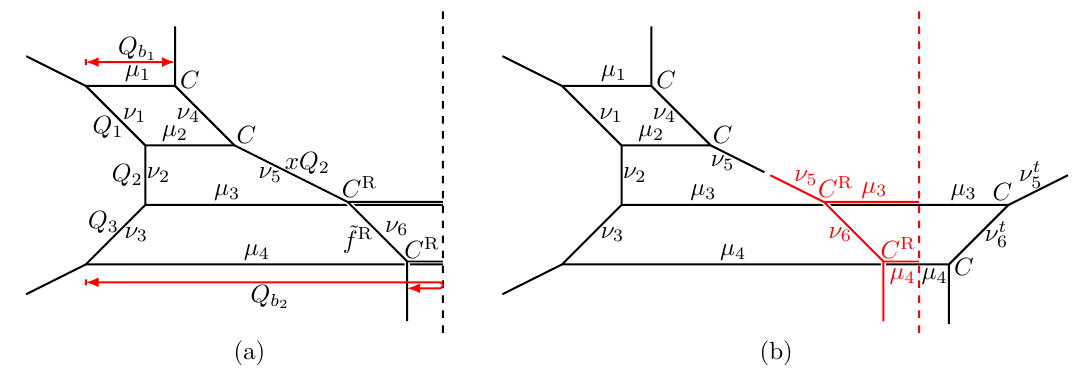
Figure 5 . 5-brane webs with an ON − -plane for D 2 ( N 1 , N 2 ) gauge theory with N 1 = 2 , N 2 = 2 . be realized by folding the right part of a 5-brane configuration in figure 5(b) to the left and then by gluing the edges in the middle. The 5-brane configuration before the folding is all equipped with the conventional vertex factors C because the diagram contains two copies of normal SU (2) webs. After the folding, on the other hand, the two vertices are reflected and they become C R on the left. The edge factor between this two vertices also changes due to the folding. The edge factor between the two C ’s on the right of the ON-plane together with the two C ’s in figure 5(b) are given by C ( t , q ) · ( − Q ) | ν 6 | ˜ f − 1 ( q , t ) · C ( t , q 3 ν t ν 6 µ 3 ν t ø µ 4 ν t 5 6 6